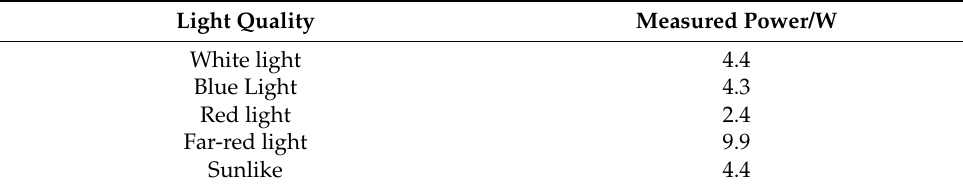
Table 8. Measured power of LED lamps with different light qualities at 10 µ mol.m − 2 . s − 1 . Light